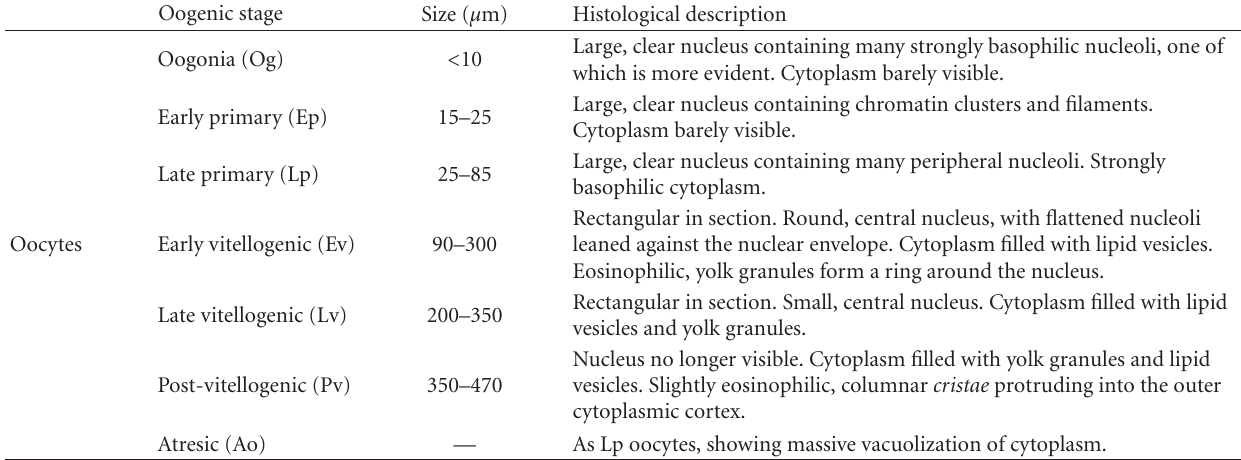
Table 3: Histological description of oocyte developmental stages in Aristaeomorpha foliacea.